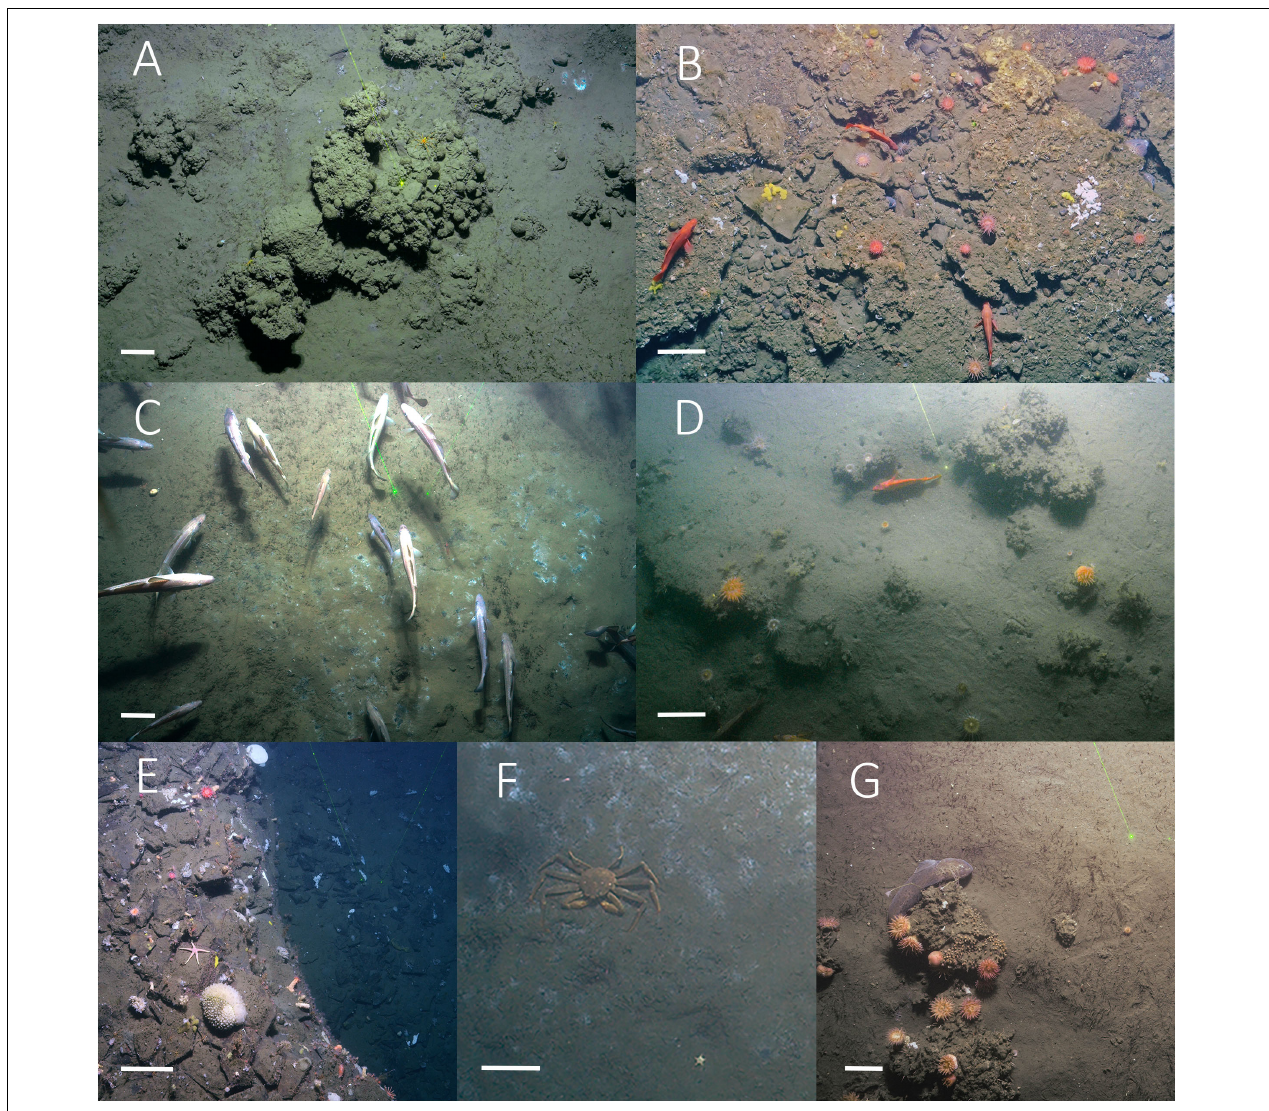
FIGURE 4 | Arctic seep habitats; heterogeneity, carbonate outcrops, and commercial species, from top left to right. (A) Carbonate outcrops, siboglinid tufts, and microbial mats at the Vestnesa seep (1,200 m) from Åström et al. (2018). (B) At the Prins Karls Forland shelf (240 m); large carbonate outcrops and glacial debris provide hard surfaces for epifauna and a varied habitat for Red rock-fish ( Sebastes sp.) and spotted wolffish ( Anarhichas minor ), from Åström (2018). (C) A school of cod ( Gadhus morhua ) swimming over mats of microbes and siboglinids at the Storfjordrenna gas hydrate mounds/pingos (380 m), from Åström (2018). (D) Red rock-fish ( Sebastes sp.) and carbonate outcrops at Storfjordrenna seep field (350 m), from Åström et al. (2019). (E) Epifaunal organisms on a rocky slope into one of the craters at the Bjørnøyrenna crater seeps (330 m), from Åström et al. (2019). (F) A snow crab feeding in a microbial mat at Storfjordrenna gas hydrate mounds/pingos (380 m), from Sen et al. (2018a). (G) A spotted wolffish ( A. minor ) carbonate crust with epifaunal anemones, hydroids, and solitary corals surrounded by siboglinid tufts at Storfjordrenna gas hydrate mounds/pingos (380 m), from Åström et al. (2019). Scale bars indicate 20